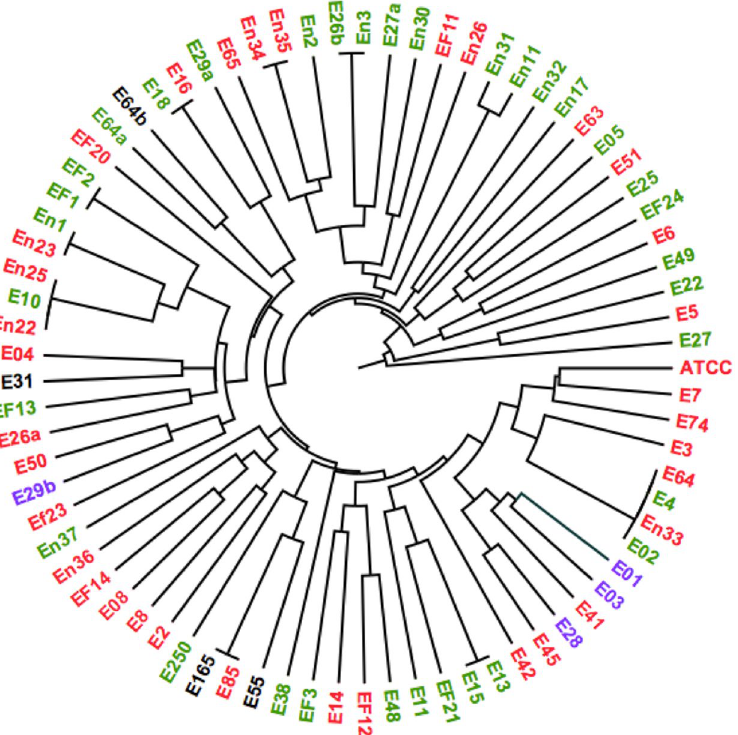
Figure 1. ERIC-PCR analysis of the isolates. An nweighted pair group method using arithmetic overage algorithm (UPGMA) dendrogram in a radial format representing the ERIC-PCR pattern relatedness of all tested isolates. Isolate names are color coded according to their biofilm strength (Purple, strong; Red, medium; Green, weak; Black,